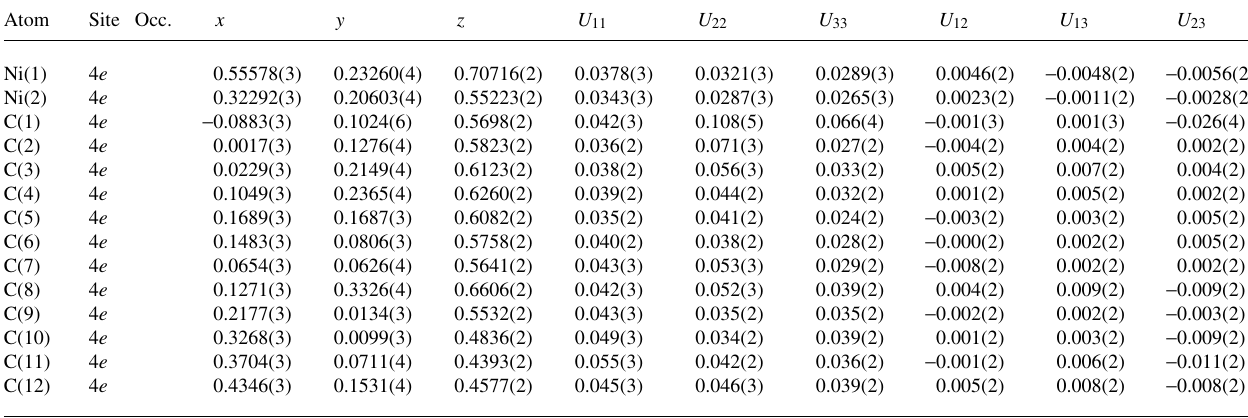
Table 3. Atomic coordinates and displacement parameters (in Å 2 )